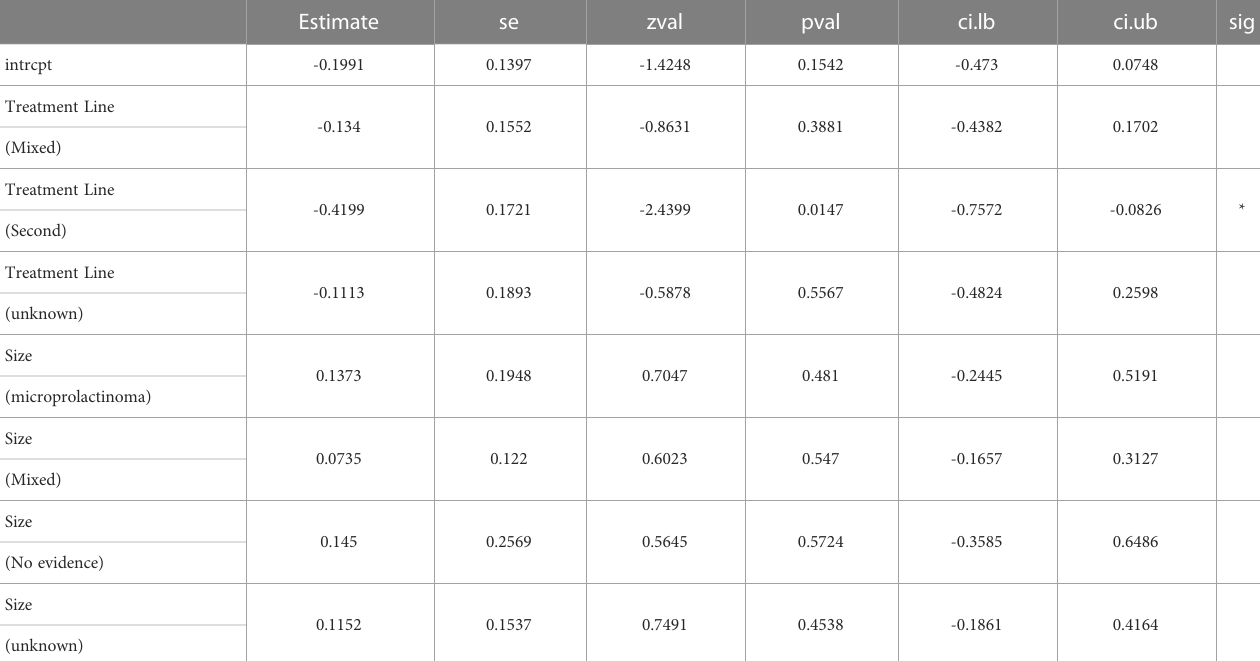
TABLE 3 Meta-regression